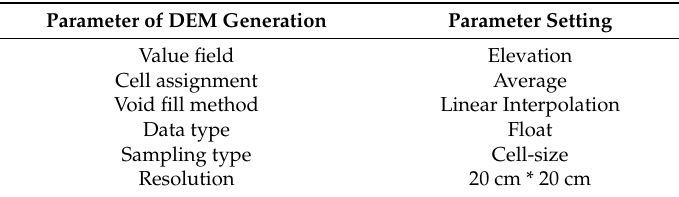
Table 1. Parameters of DEM generation.